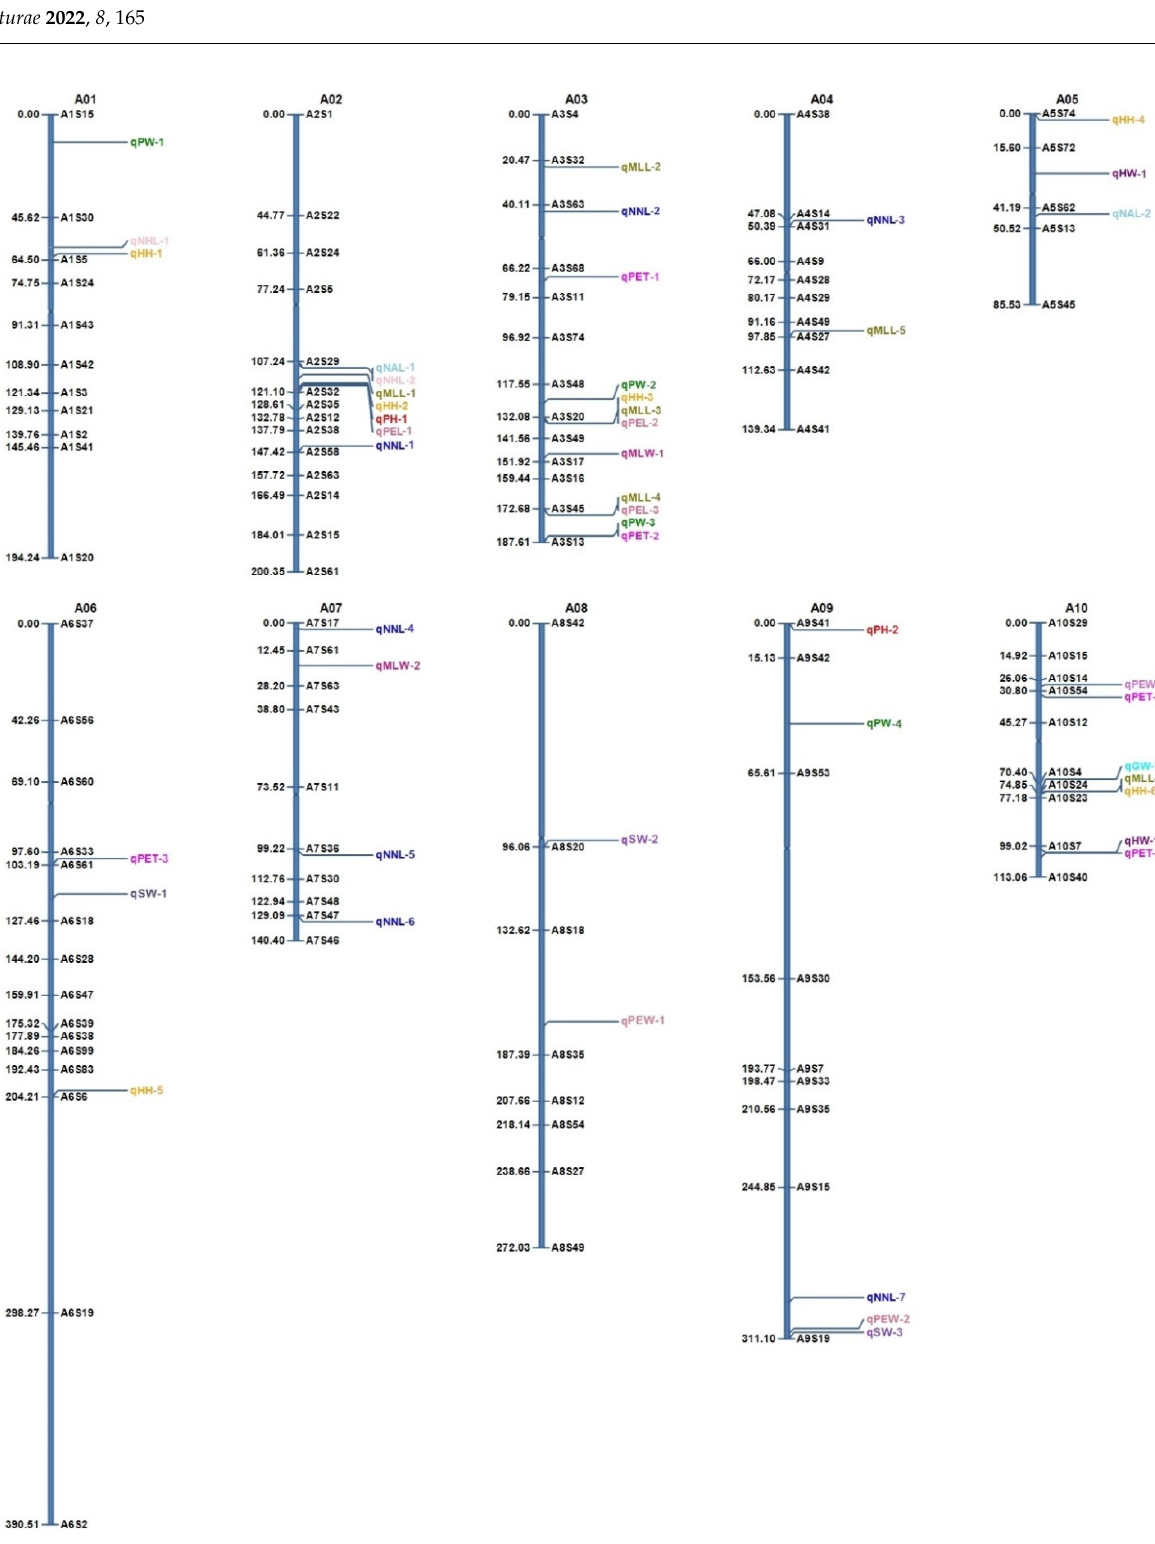
Figure 1. Brassica rapa genetic linkage map and QTLs for agronomic traits discovered in F 2 lines. Genetic distances (cM) are shown on the left side of the linkage group, and the names of the SSRs are shown on the right side of the linkage group.